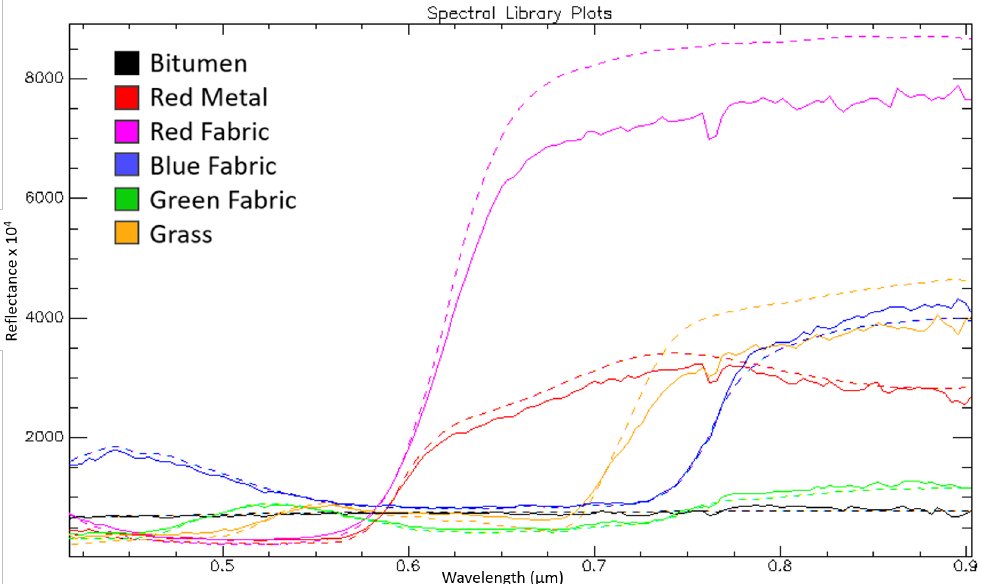
Figure 5. Spectral library manually extracted from the HySpex image (solid lines) compared to mean SVC acquisitions (dashed lines). The HySpex spectra are selected in the center of the corresponding 3m targets (marked in white in Figure 4d), while the grass spectrum represents the dominant background. The individual SVC acquisitions leading to the mean SVC measurement shown here can be found in Figure A1. Wavelengths are expressed in